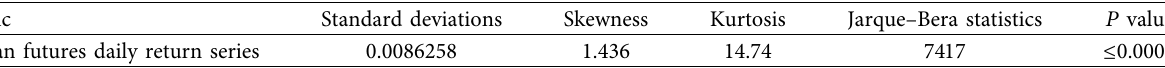
Table 2: Stability test of China’s soybean futures yield series.